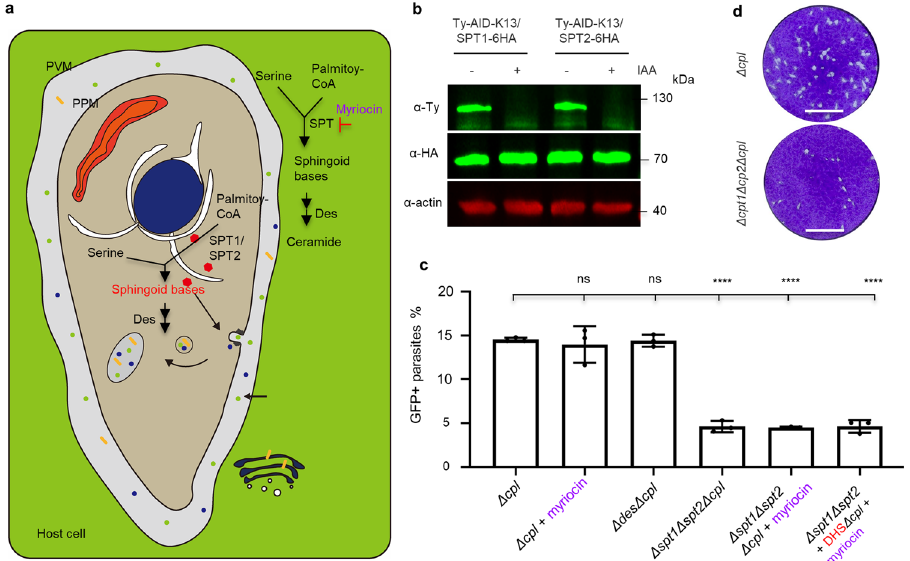
Fig. 5 | The micropore endocytosis requires ceramide de novo synthesis. a Modelofceramidedenovosynthesisintheendoplasmicreticulum(ER)andGolgi of parasites and host cells. Sphingoid bases include 3-ketodihydroxysphingonine (KDS) and dihydrosphingosine (DHS), sequentially catalyzed by SPT and a reduc- tase, and fi nallyforming ceramide bymeansofadesaturase (Des). b LevelsofSPT1 and SPT2 showed no changes upon depletion of Kelch13. SPT1 and SPT2 were separately tagged with 6HAin the AID-Kelch13 line, and the lines were grown ±IAA for 36h. c Parasite ceramide de novo synthesis pathway is required for the